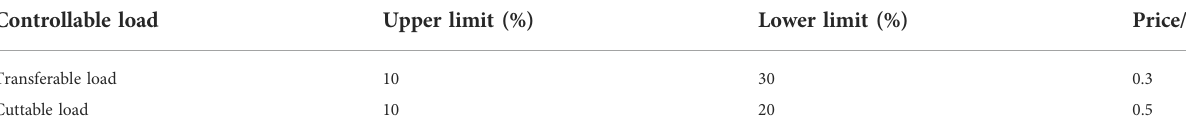
TABLE 1 Parameters of the controllable load in the